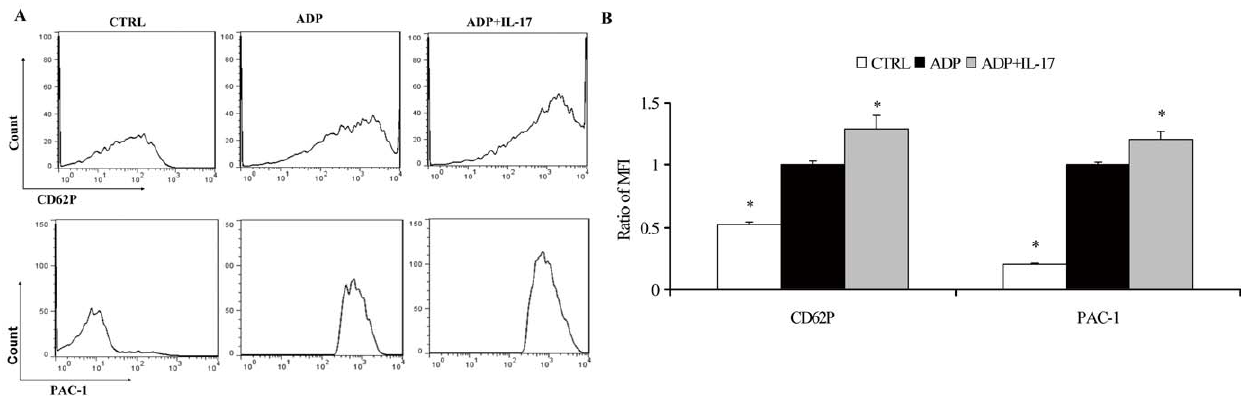
Figure 3. The role of IL-17A in the platelet activation. (A) Representative pictures for the CD62P and PAC-1 MFI in CTRL, ADP and ADP + IL-17A groups. (B) The results of statistical analysis for the ratio of CD62P and PAC-1 MFI in CTRL, ADP and ADP + IL-17A groups. *, p , 0.05 vs ADP group. Values are means 6 SEM of five independent experiments with different donor platelets.